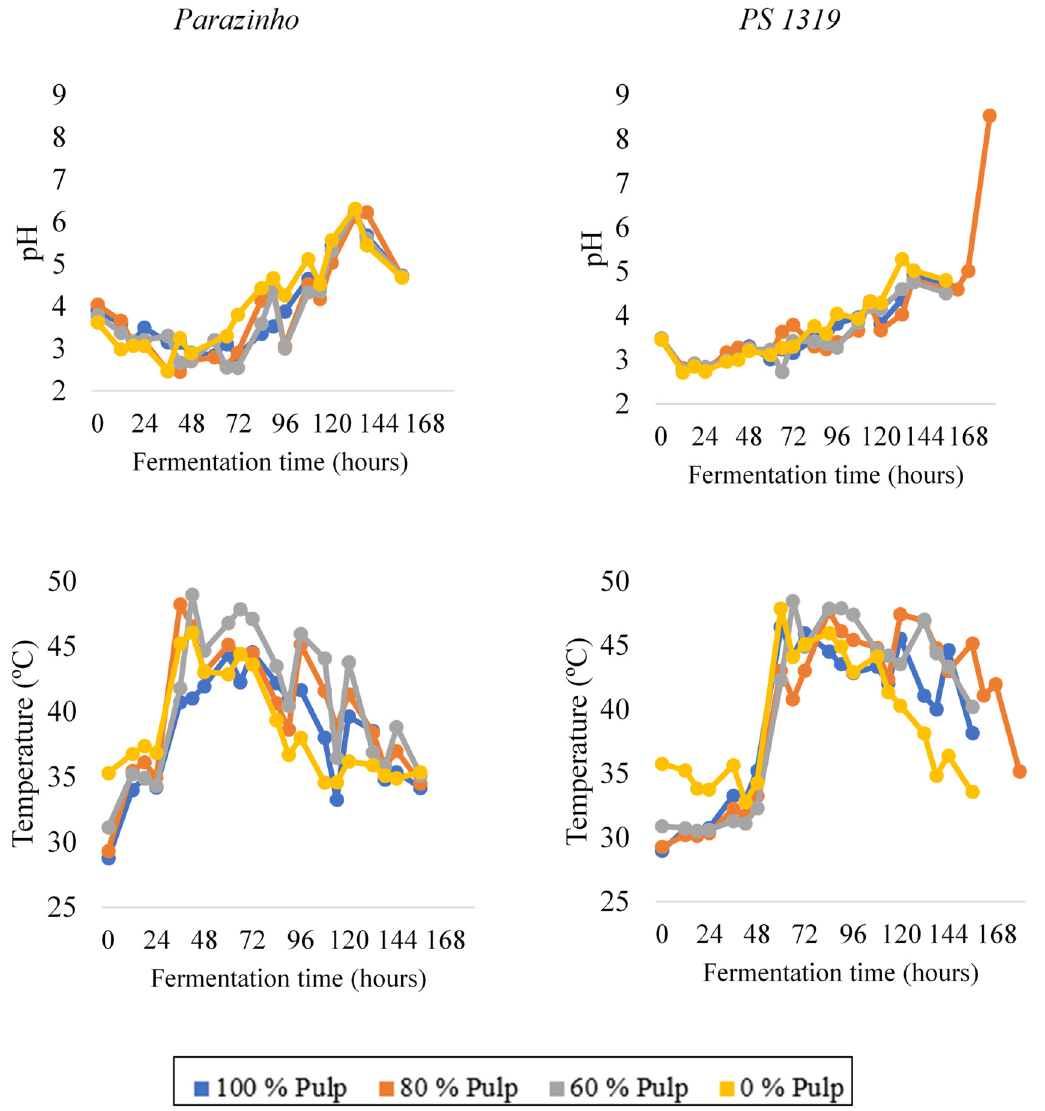
Figure 1. Temperature and pH changes during on-farm fermentation of two varieties of cocoa (PS 1319 and Parazinho) from Bahia, Brazil, using different proportions of pulp (100, 80, 60, and 0%).